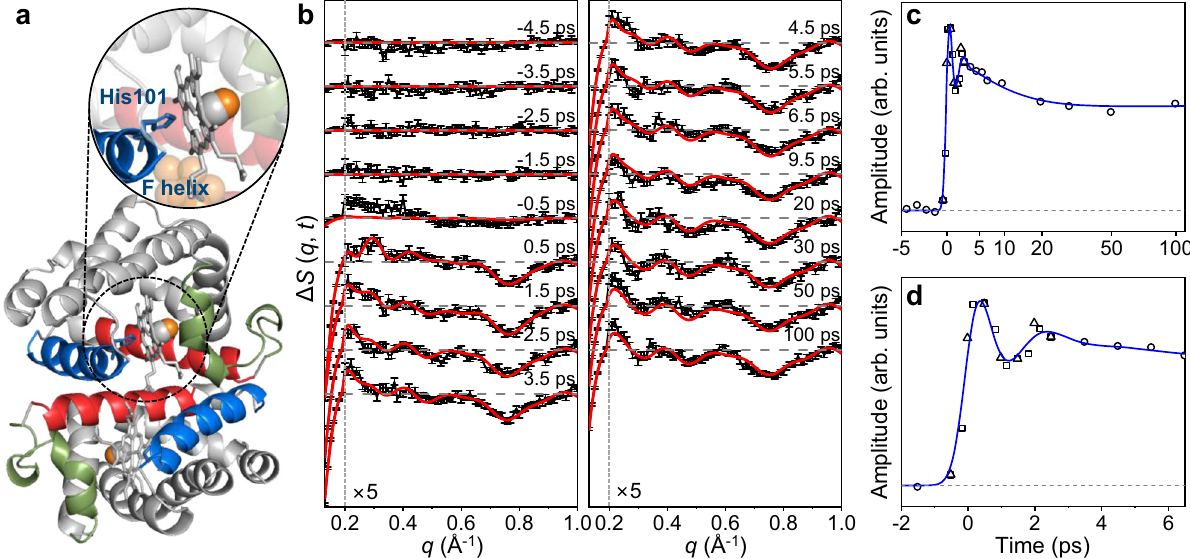
Fig. 1 TRXSS data of HbI and temporal oscillation of the signal. a A crystal structure of HbI(CO) 2 (bottom) and an enlarged view of the heme group and the His101 residue (top) (PDB entry: 3sdh). The C helix with the CD loop, the E helix, and the F helix are indicated with green, red, and blue colors, respectively. The CO ligand molecules are indicated with spheres. The photodissociation of a ligand molecule that is bound to a heme group induces the structural transition of the heme and the overall protein, called the R-T transition. b The experimental femtosecond TRXSS data (black) and calculated curves (red) from − 4.5 to 100 ps. The calculated curve at each time delay shown in red was generated by taking a linear combination of the theoretical difference scattering curves of the reaction intermediates (I 0 , I 1 , I 0 U , and I 0 D ) obtained from the structural re fi nement. For each species, the scattering curves of the candidate structures obtained from structure re fi nement were averaged to generate the corresponding theoretical difference scattering curve (see the Supplementary Information for detailed information). The coef fi cients for the linear combination were determined by the concentrations of the reaction intermediates at each time delay. For clarity, the high q region with q ≥ 0.2 Å − 1 is scaled up by 5. c , d The fi rst rSVs multiplied by their singular values obtained from the SVD results of the 333-fs-binned data (square), 500-fs-binned data (triangle), and 1-ps-binned data (circle) are plotted for c the full and d early time domains (<6.5 ps). The fi rst rSVs multiplied by their singular values were fi tted with a kinetic function convoluted with an instrument response function with 800-fs FWHM. The fi t kinetic function (blue curve) consists of an exponential decay function with a time constant of 8.7 ps (±0.6) and a damped cosine function with a damping time constant of 800 fs (±100) and a wavenumber of 13 cm − 1